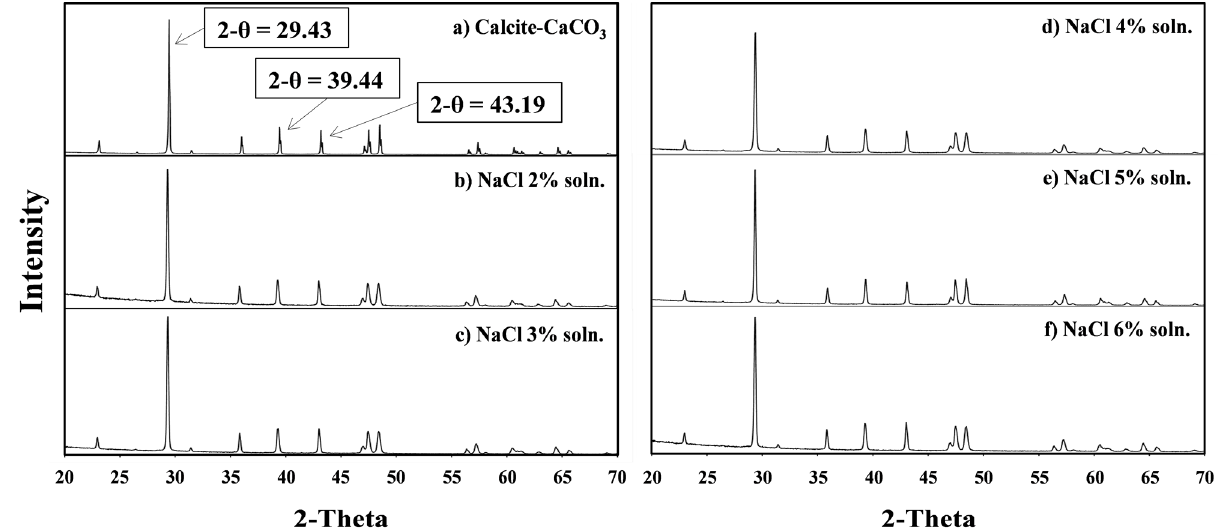
( b ) NaCl 2% soln; ( c ) NaCl 3% soln; ( d ) NaCl 4% soln; ( e ) NaCl 5% soln; ( f ) NaCl 6%